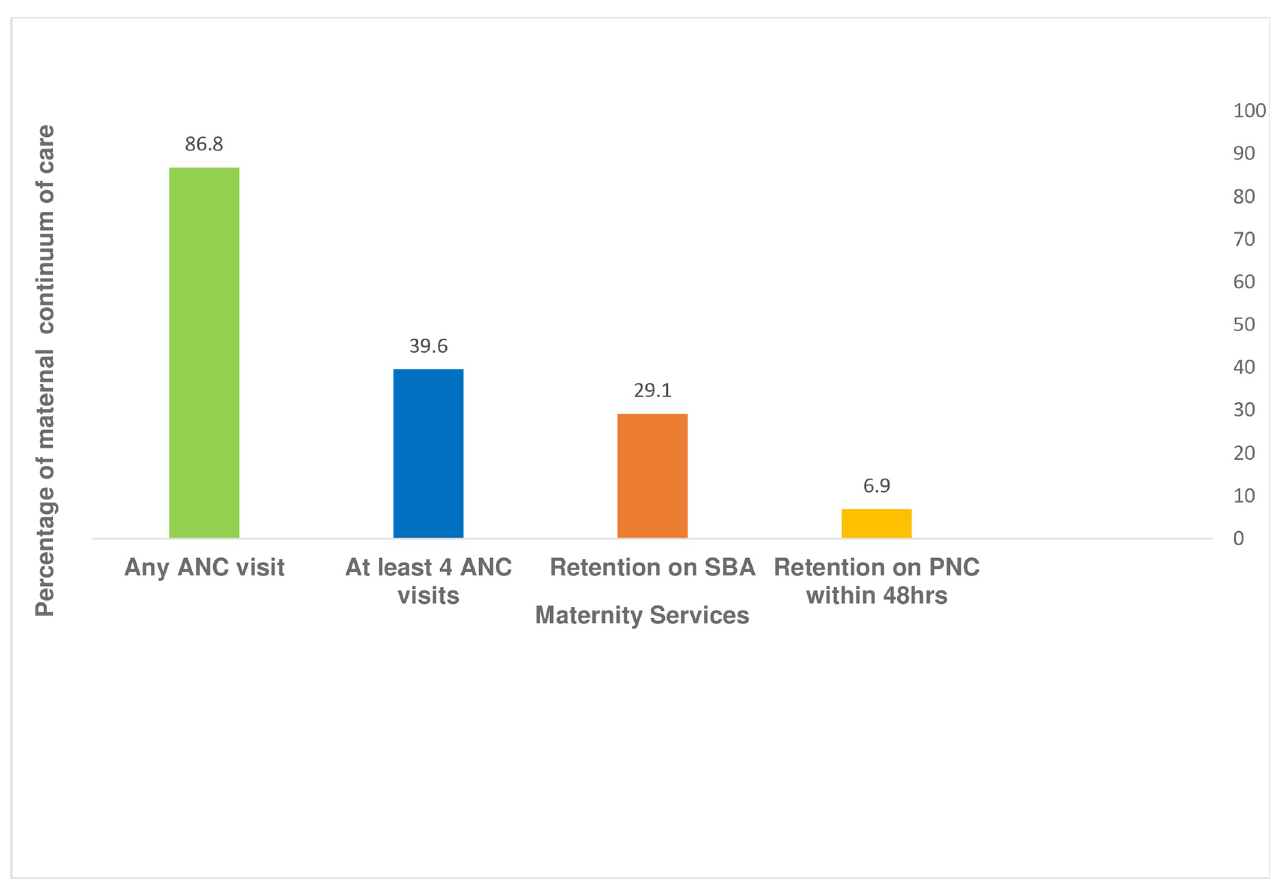
Fig 1. Maternal health service utilization in completion of maternal continuum of care from ANC to PNC care within 48hrs after birth in Northwest Ethiopia, 2020.